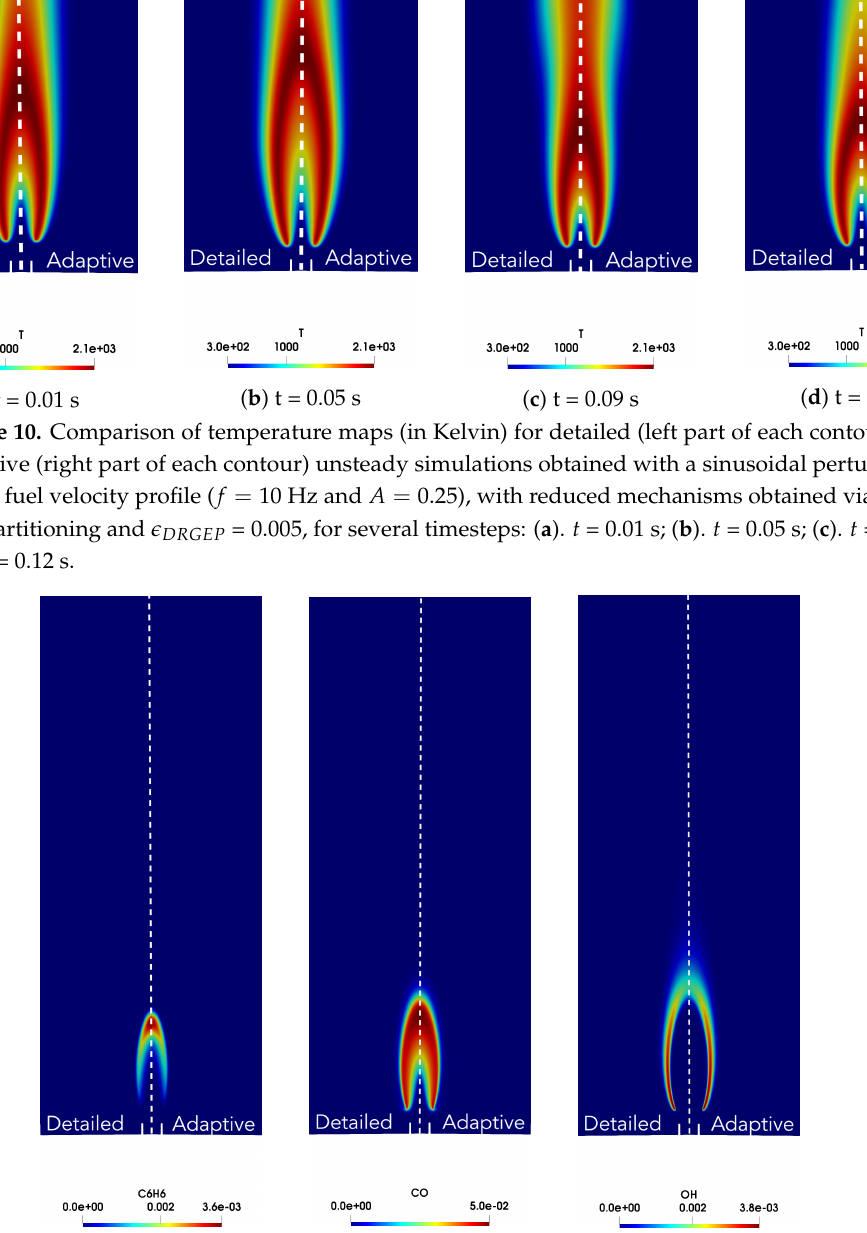
Figure 11. Comparison of species maps (from left to right: C 6 H 6 , CO, OH) for detailed (left part of each contour) and adaptive (right part of each contour) unsteady simulations obtained with a sinusoidal perturbation in the fuel velocity profile ( f = 10 Hz and A = 0.25), with reduced mechanisms obtained via LPCA pre-partitioning and (cid:101) DRGEP = 0.005, t = 0.12